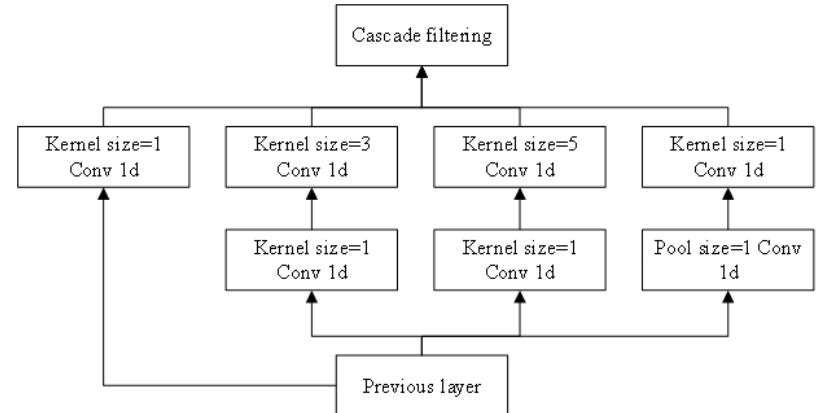
Fig. 7. The extended Inception module.